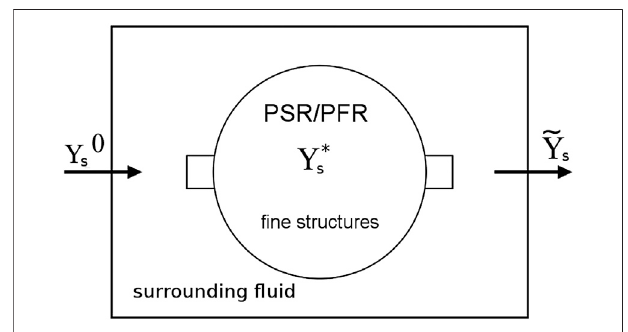
Figure 1 | Conceptual drawing of the reactor based